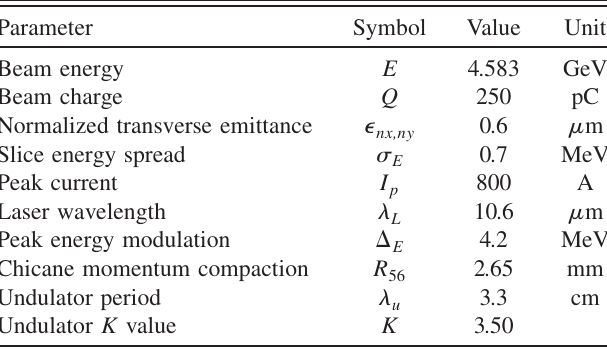
TABLE I. Parameters of the electron beam and undulators.